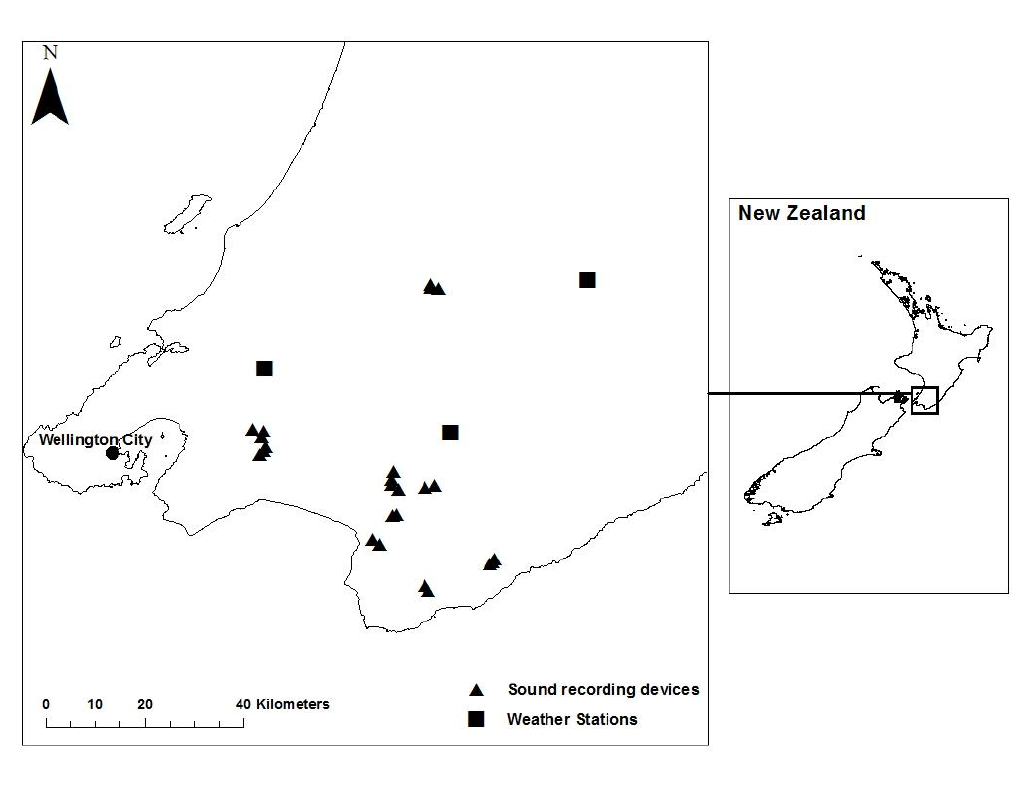
Figure A1.1. Location of sound recording devices across the lower North Island of New